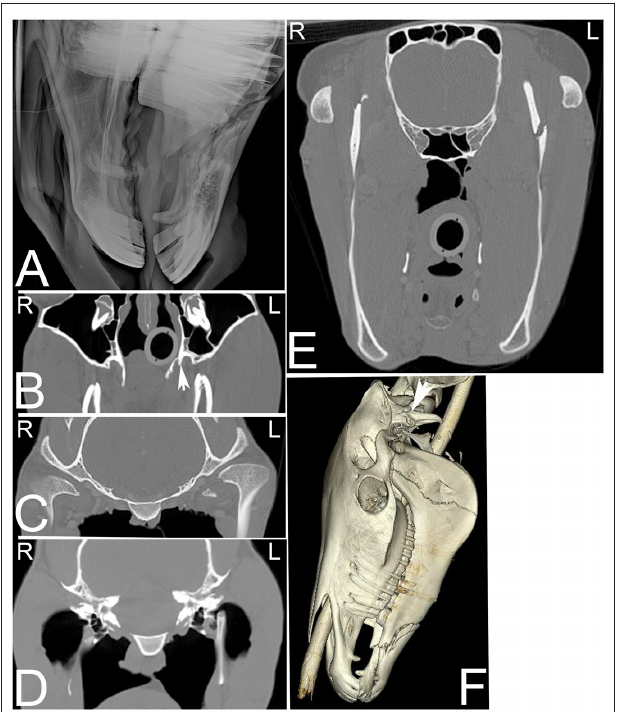
FIGURE 14 | Extensive head trauma. Radiographic and computed tomography images of the head of a 6-year-old American Saddle horse gelding with a history of acute trauma and swelling of the left side of the head and right eye region on physical examination. On the radiograph (A) a long oblique fracture of the body of both mandibles with involvement of the roots of both second mandibular premolar teeth is noted. On transverse CT images (B–E) displayed in a bone window additional fractures involving the left pterygoid process ( B , arrow), medial aspect of the left condyloid process of the mandible (C) , the dorsal aspect of the left stylohyoid bone (D) and the ramus of the left mandible (E) are noted. On the 3-dimensional reconstructed CT image (F) , the fracture of horizontal ramus (body) of both mandibles and the vertical ramus of the left mandible as well as a fracture of the left paracondylar process (arrow) can be noted. L, left; R, right.